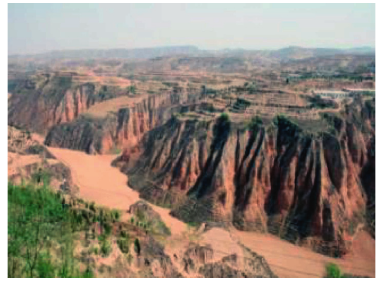
Figure 1: Loess landform.